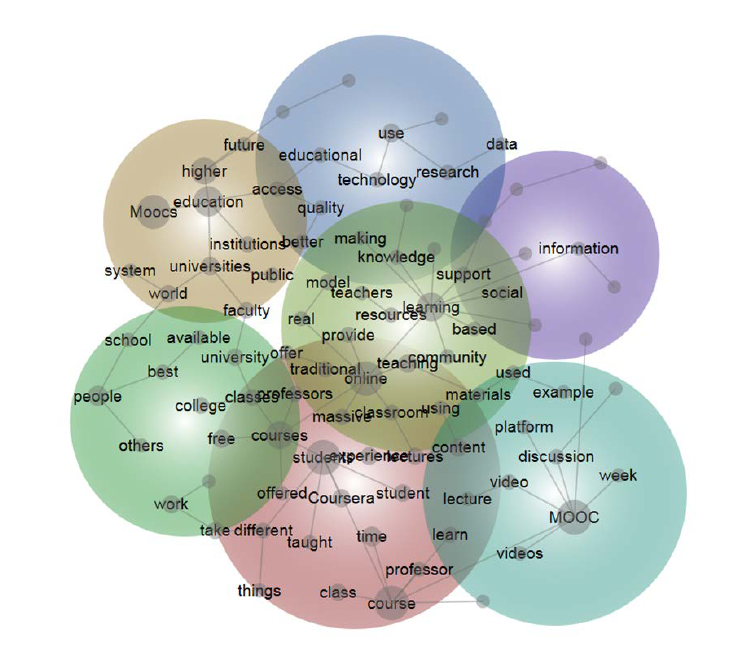
Figure 2 . A concept map example generated by Leximancer from the sample